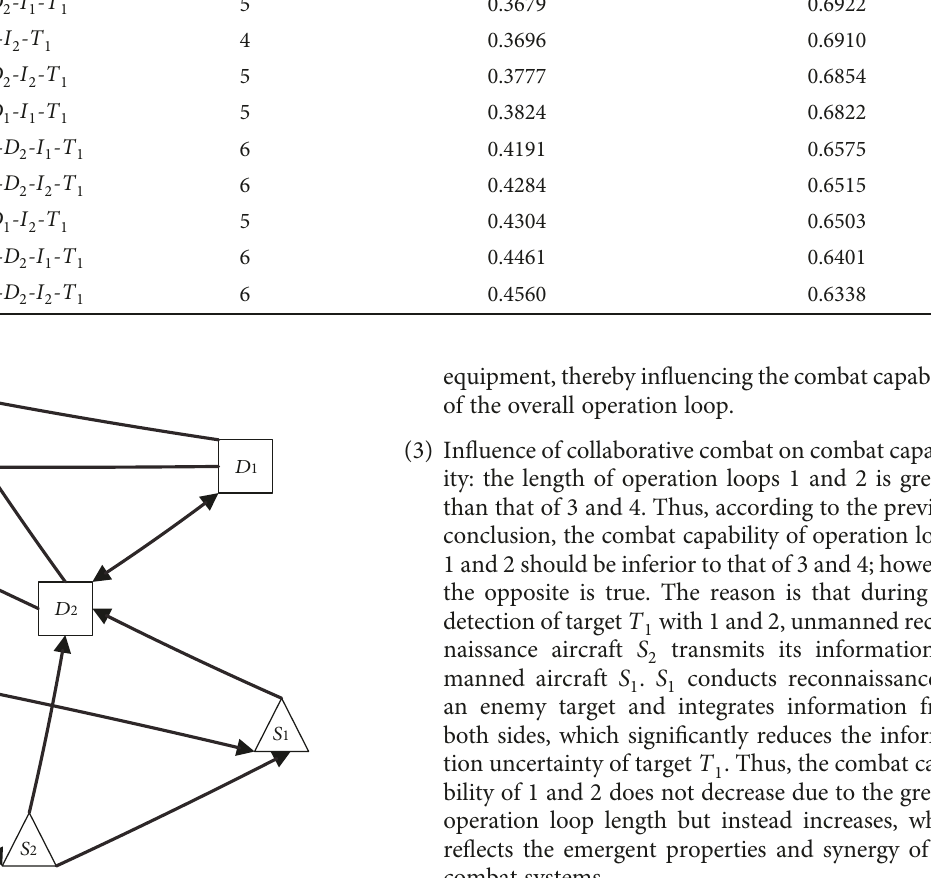
Figure 5: MAV/UAV collaborative combat network aimed at target T 2